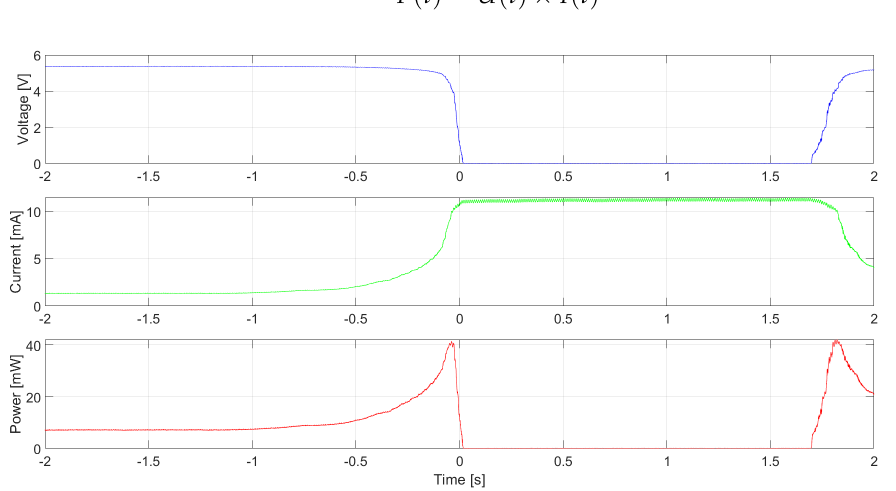
Figure 12. Exemplary screenshot from a digital oscilloscope. Voltage (yellow), current (teal) and power (red) waveforms in time